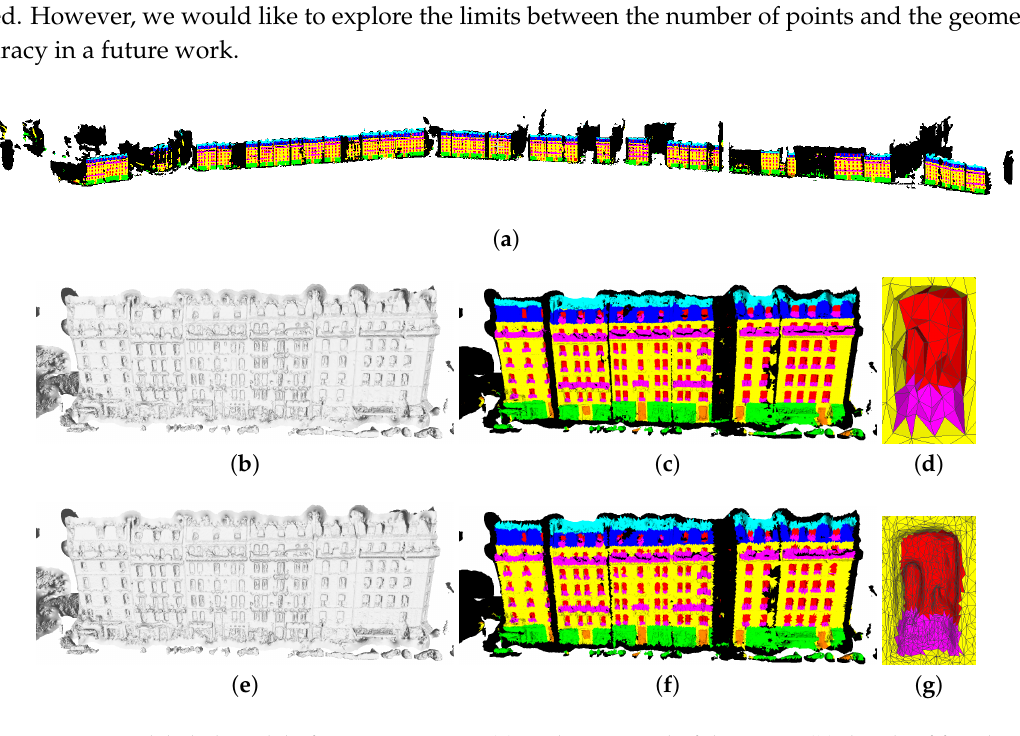
Figure 12. 3D-labeled model of RueMonge2014. ( a ) Wide view and of the street; ( b ) details of façade geometry by a sparse point cloud; ( c ) its labels after ray-tracing analysis; ( d ) close look of the 3D window labels; ( e ) the façade geometry by a dense point cloud and ( f ) its labels; and ( g ) close look of 3D window labels.